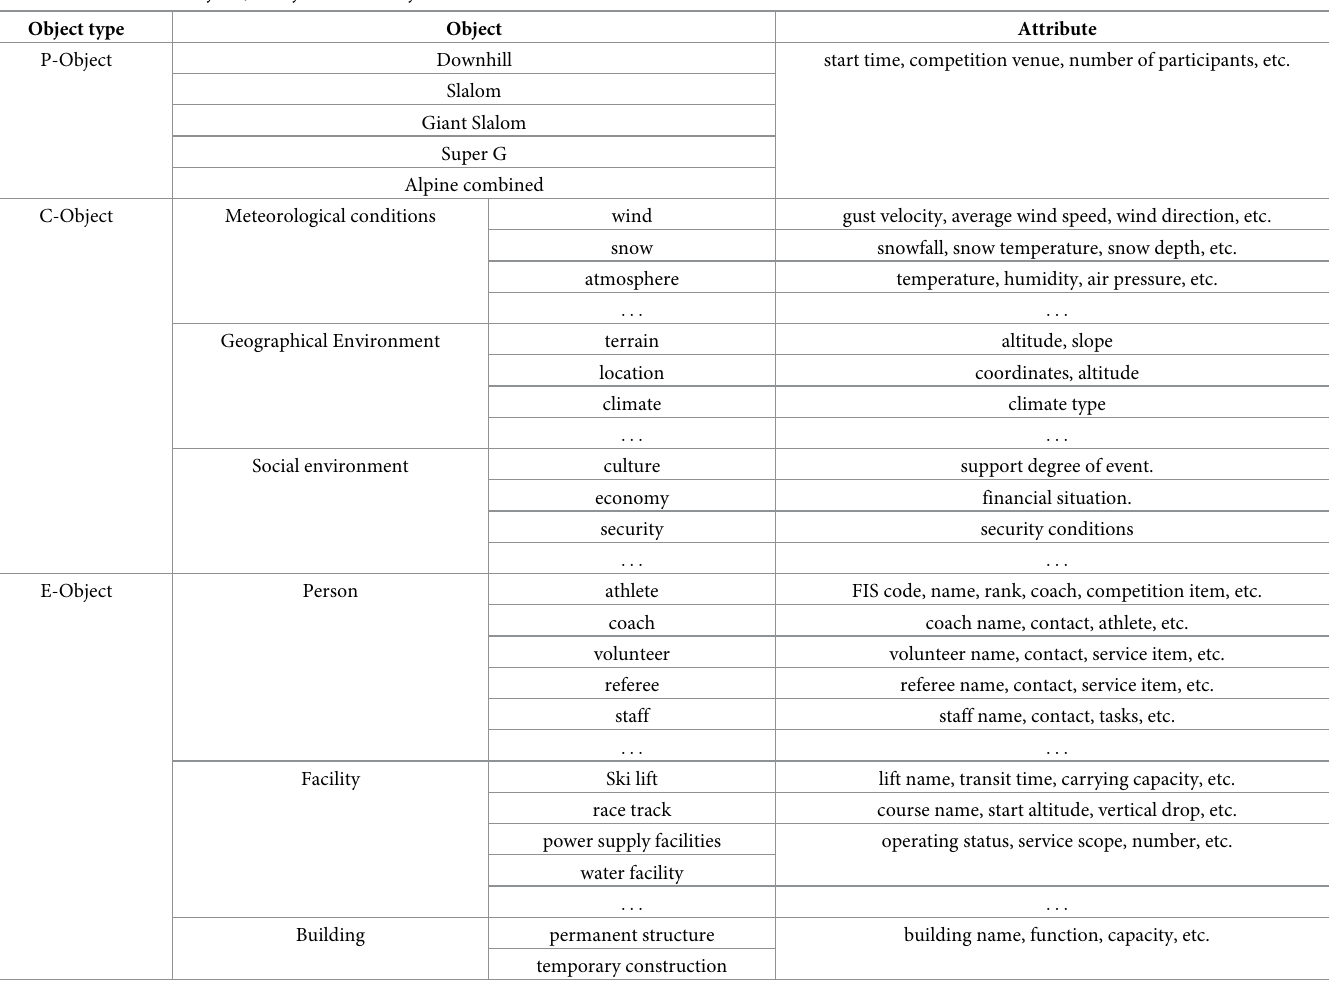
Table 1. Attribute of C-objects, P-objects and E-objects.